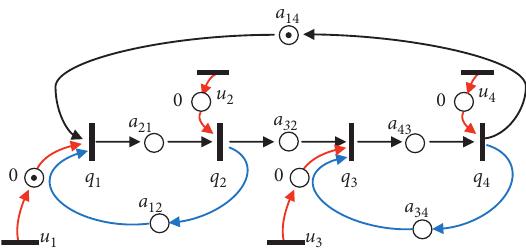
Figure 4: Timed event graph of autonomous-controlled lower limb walking.